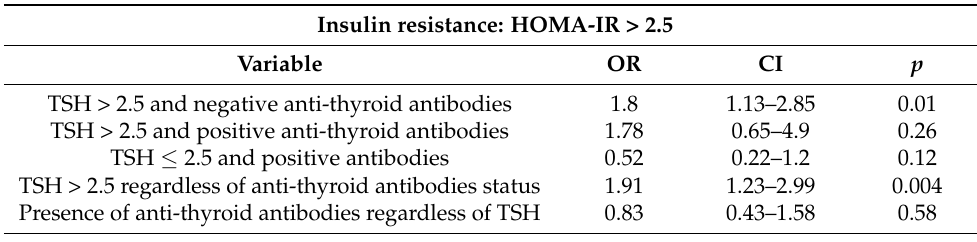
Table 3. Logistic regression model results for selected parameters in subpopulations of women with